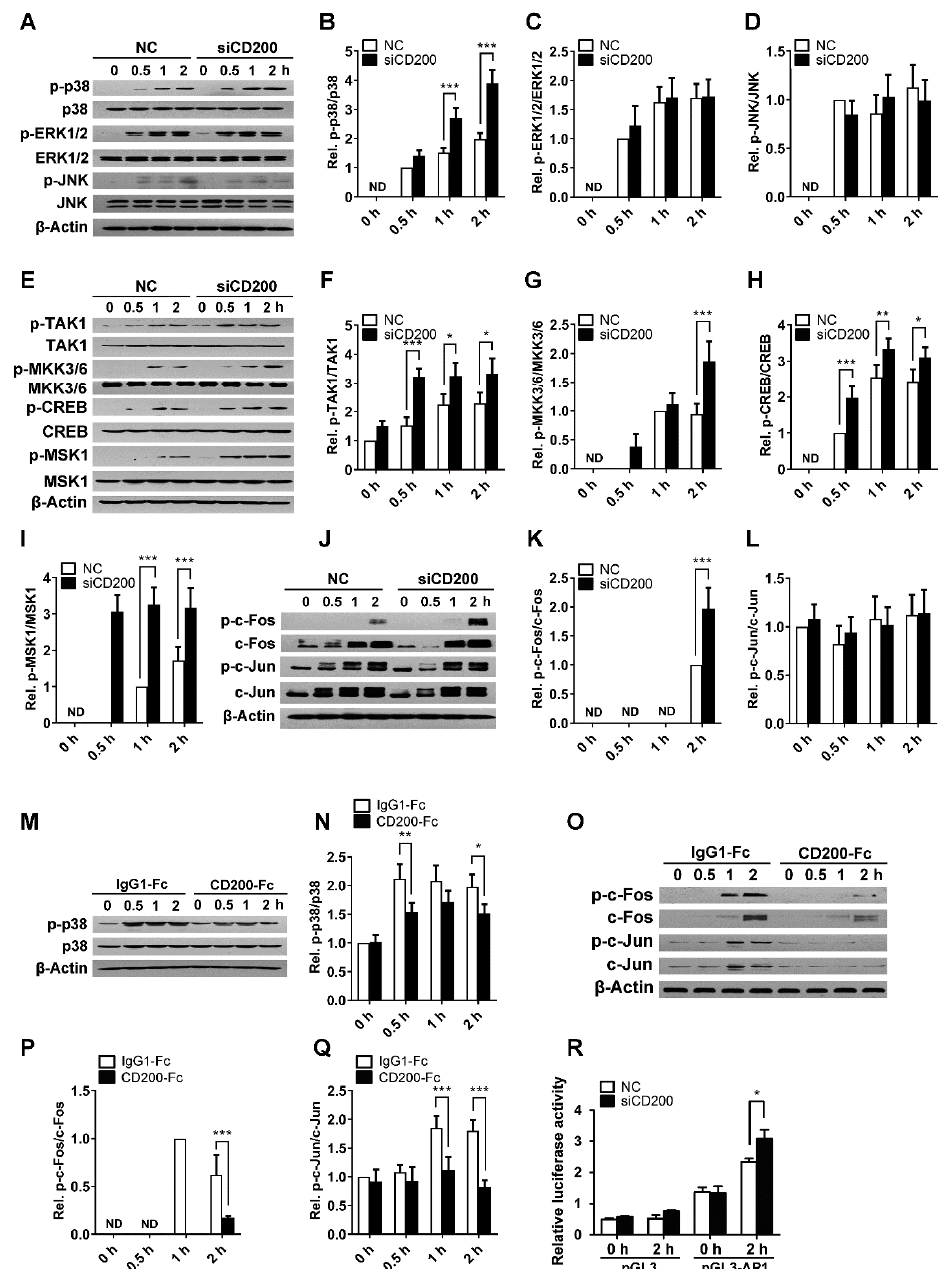
Figure 6. CD200 restrains p38 signaling upon Staphylococcal infection. ( A – L ) Mouse PEMs were transfected with CD200 siRNA (siCD200) or control siRNA (NC) for 48 h, and then stimulated with S. aureus (MOI = 1) for indicated time periods. The protein expression levels of p-p38, p38, p-ERK1/2, ERK1/2, p-JNK, JNK, p-TAK1, TAK1, p-MMK3/6, MMK3/6, p-CREB, CREB, p-MSK1, MSK, p-c-Fos, c-Fos, p-c-Jun, and c-Jun were detected by western blotting. ( M – Q ) Mouse BMDMs were pre-treated with CD200-Fc (2 μ g/mL) or IgG1-Fc (2 μ g/mL) for 1 h, and then stimulated with S. aureus (MOI = 1) for indicated time periods. The protein expression levels of p-p38, p38, p-c-Fos, c-Fos, p-c-Jun, and c-Jun were detected by western blotting. ( R ) RAW264.7 macrophages were pre-transfected with CD200 siRNA for 48 h and then challenged with S. aureus (MOI = 10) for 2 h. The AP-1 luciferase activity was analyzed by the dual luciferase. Representative blots from three independent experiments are shown ( A , E , J , M , and O ). Changes in the phosphorylation state of different proteins were semi-quantitated using ImageJ software ( B – D , F – I , K – L , N , P – Q ). ND means not detected; * p < 0.05, ** p < 0.01, *** p <